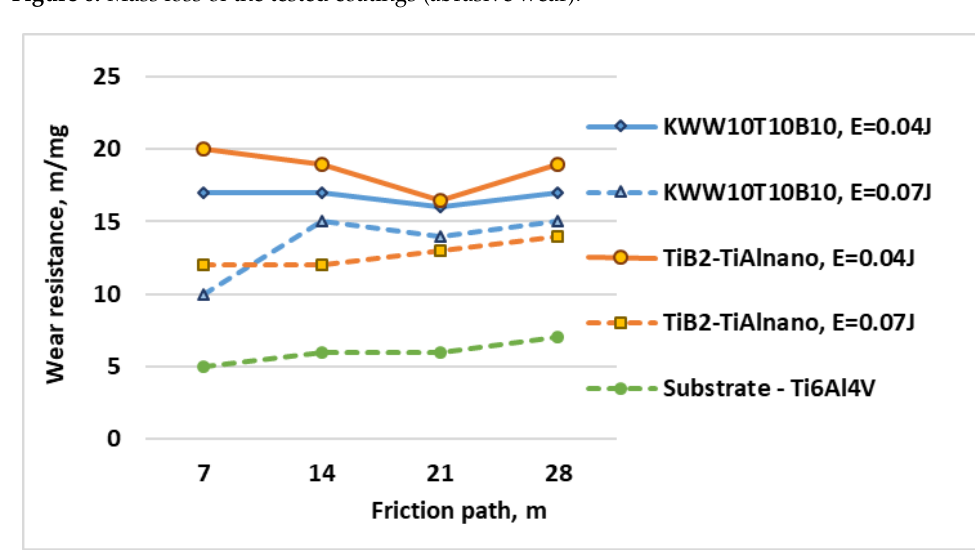
Figure 7. Wear resistance of the tested coatings (abrasive wear).